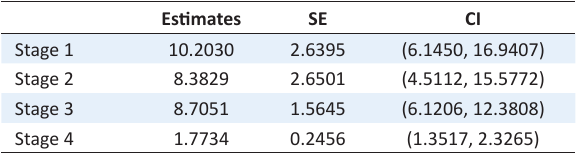
Table 3. Mean sojourn times at different stages